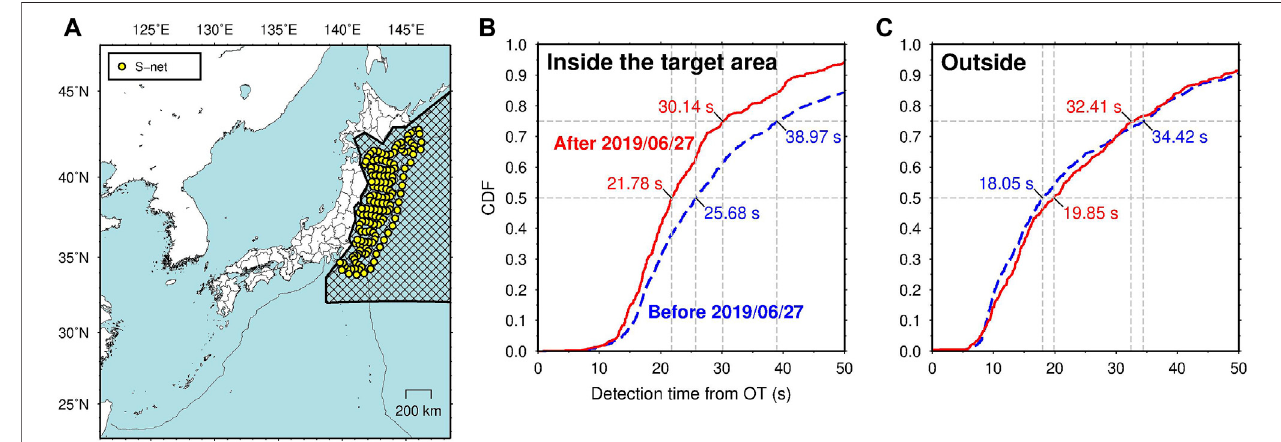
FIGURE 6 | (A) The target area for the detection time analysis for S-net (shaded area) and the locations of S-net stations. (B) the CDFs of detection times for earthquakes inside the target area before and after June 27, 2019, the start date for the S-net incorporation (that is, from April 1, 2016 to June 27, 2019 and from June 27, 2019 to December 31, 2020; blue broken and red solid lines, respectively). The detection time means the time when the JMA EEW system issued the fi rst EEW report. The detection times for CDF values of 0.50 and 0.75 are shown. OT, origin time. (C) The same fi gure as (B) but for earthquakes outside the target area.